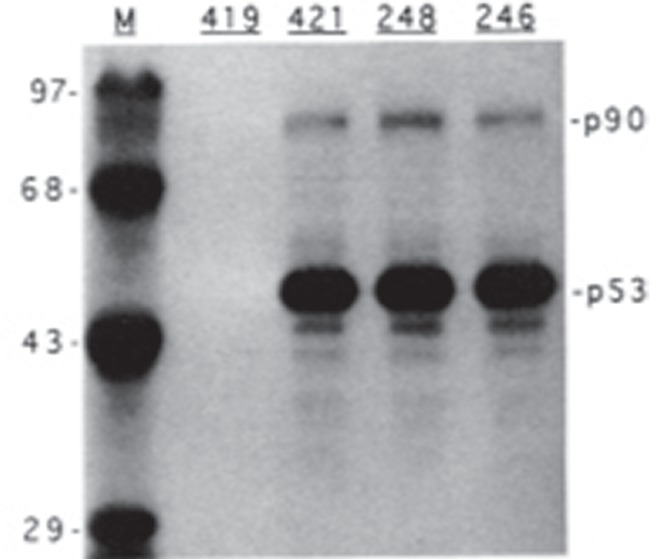
Autoradiogram of p53 immunoprecipitation from metabolically labelled cells (copied from Momand et al., 1992).